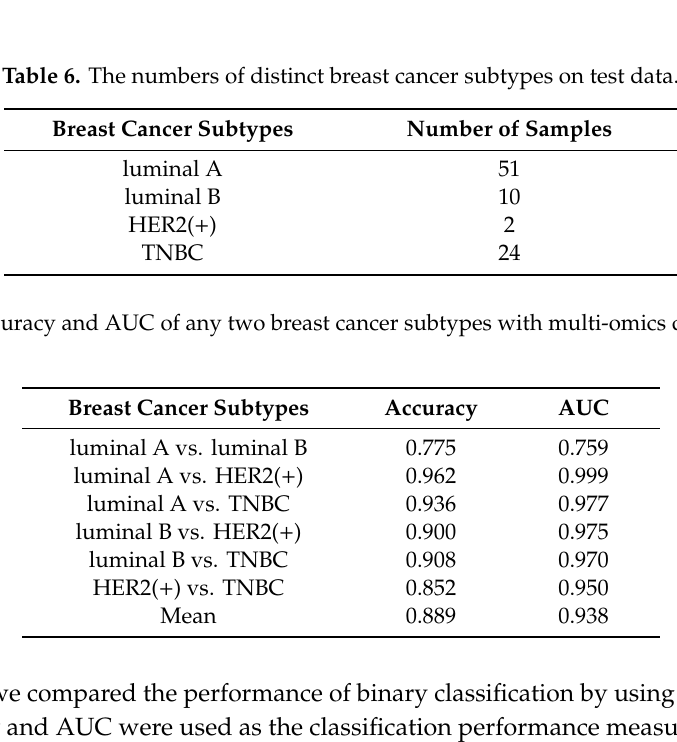
Figure 3. The AUCs by using MKL and DeepMO on binary classification. 3.2. The Performance of Multi-Classification To better evaluate the performance of the proposed model, we used the model to predict breast cancer subtypes based on multi-classification. First, we compared the accuracy of multi-classification between DeepMO using single omics data and multiple omics data. The mean accuracy of 5-fold cross-validation on all subtypes of breast cancer by using single omics data and combining three omics data is shown in Figure 4. From the figure, we can conclude that DeepMO was superior to single omics data on multi-classification.